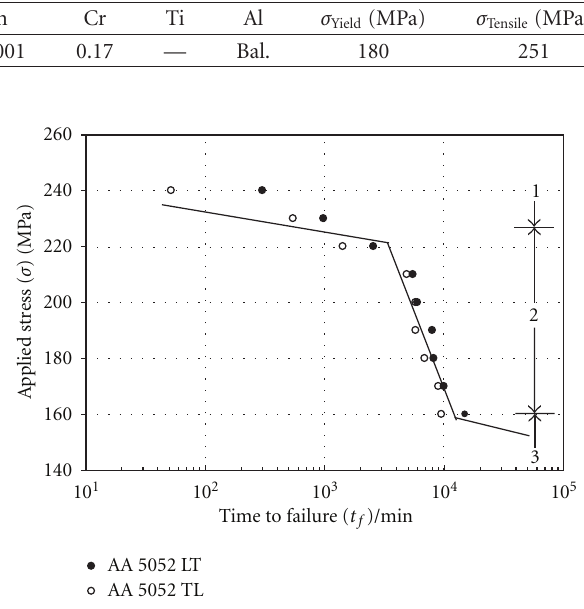
Figure 3: The logarithm of time to failure ( t f ) versus applied stress ( σ ) for A5052-H3 in a 0.5 M sodium chloride